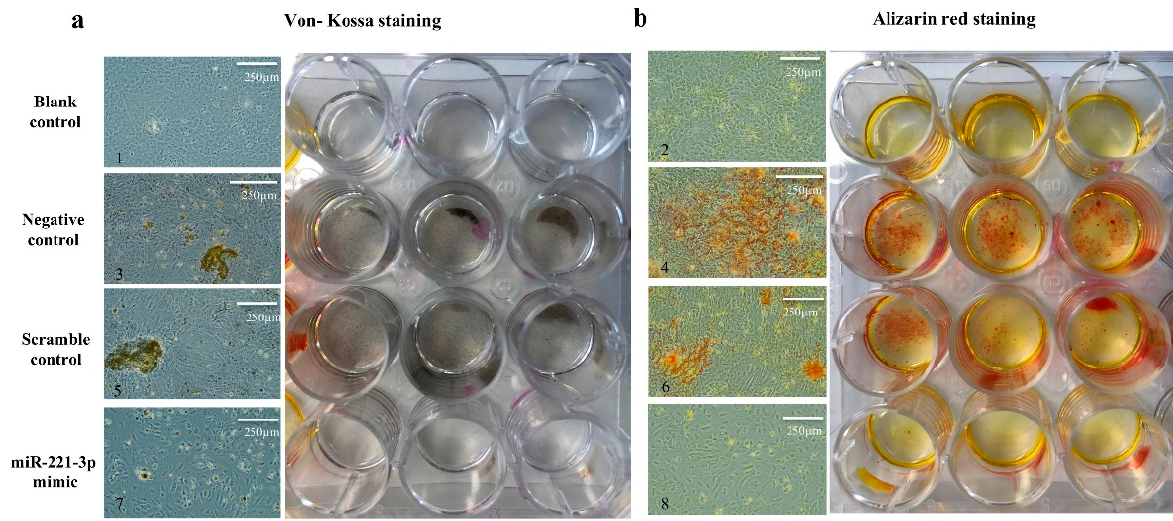
Figure 4. MiR-221-3p decreases osteoblast mineralization. The microscopic and macroscopic results of Von Kossa staining ( a ) and Alizarin Red staining ( b ) for osteoblasts after 2 weeks’ culture in different conditions. Negative control without miRNA treatment (3, 4), scramble control (5, 6) and miR-221-3p mimic (7, 8) were cultured with ODM. The undifferentiated blank control group (1, 2) was cultured with BM. BM = Basal medium, ODM = Osteogenic differentiation medium.